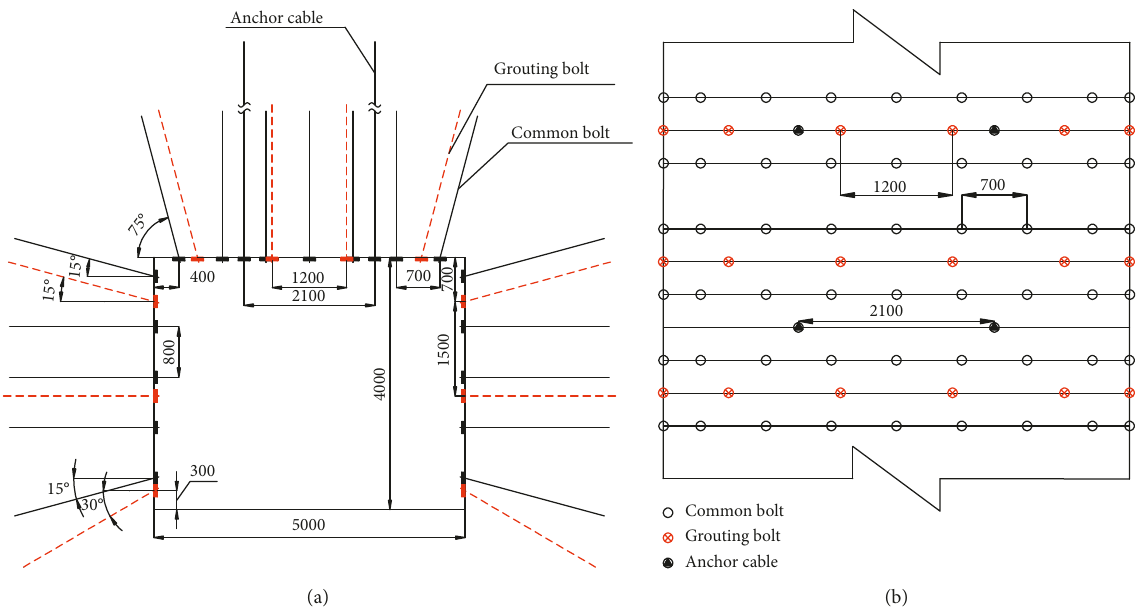
Figure 9: The scheme of bolt-grouting combined support: (a) roadway support section and (b) roadway support